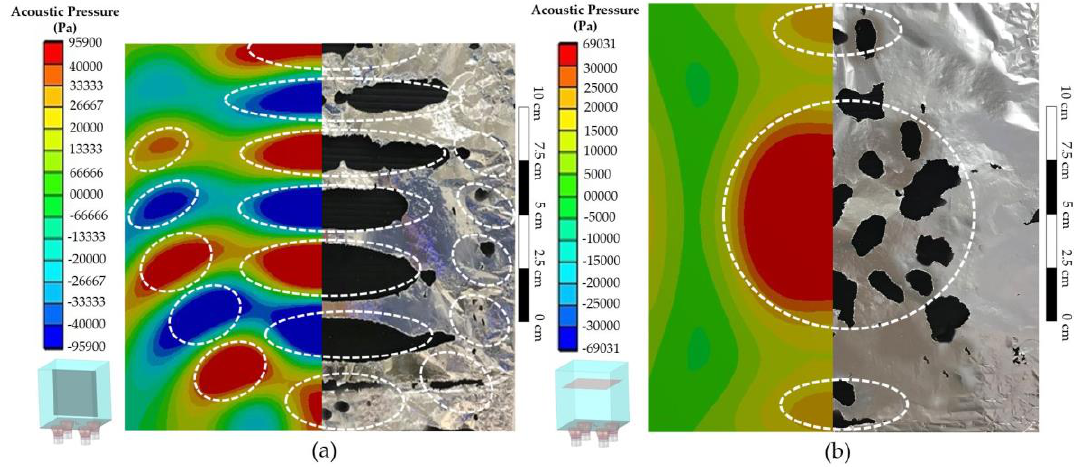
Figure 6. Acoustic pressure distribution in some areas inside the UCT compared to the results from foil corrosion test ( a ) at a height of 5.5 cm in vertical plane from the bottom and ( b ) at a depth of 5 cm from the water surface in a horizontal plane.